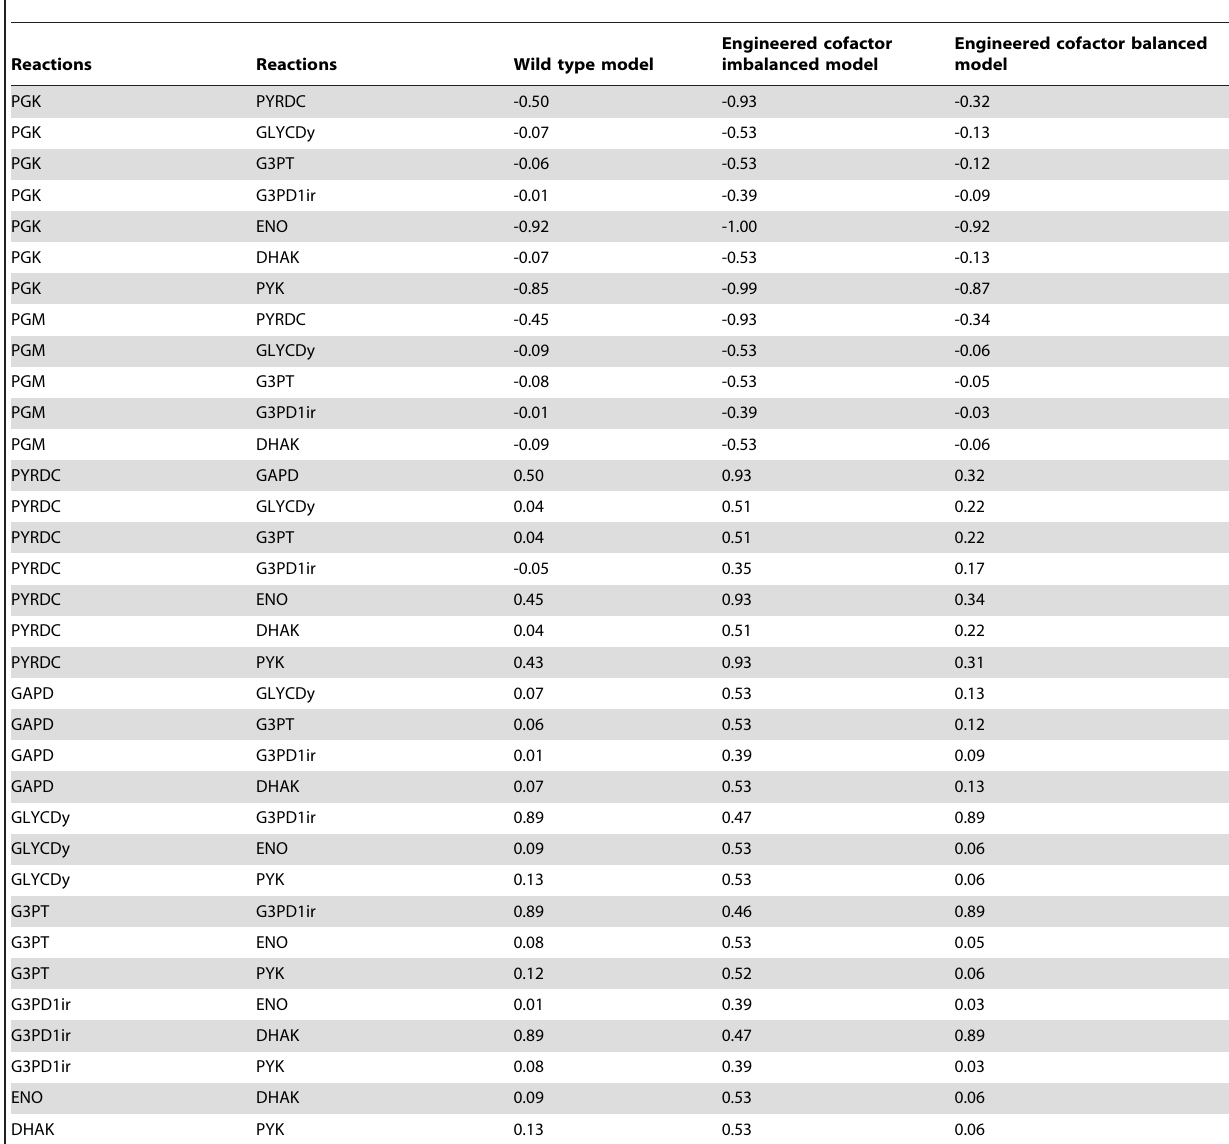
Table 3. Correlation coefficients for reaction pairs were obtained for simulated wild type, engineered cofactor imbalanced and engineered cofactor balanced